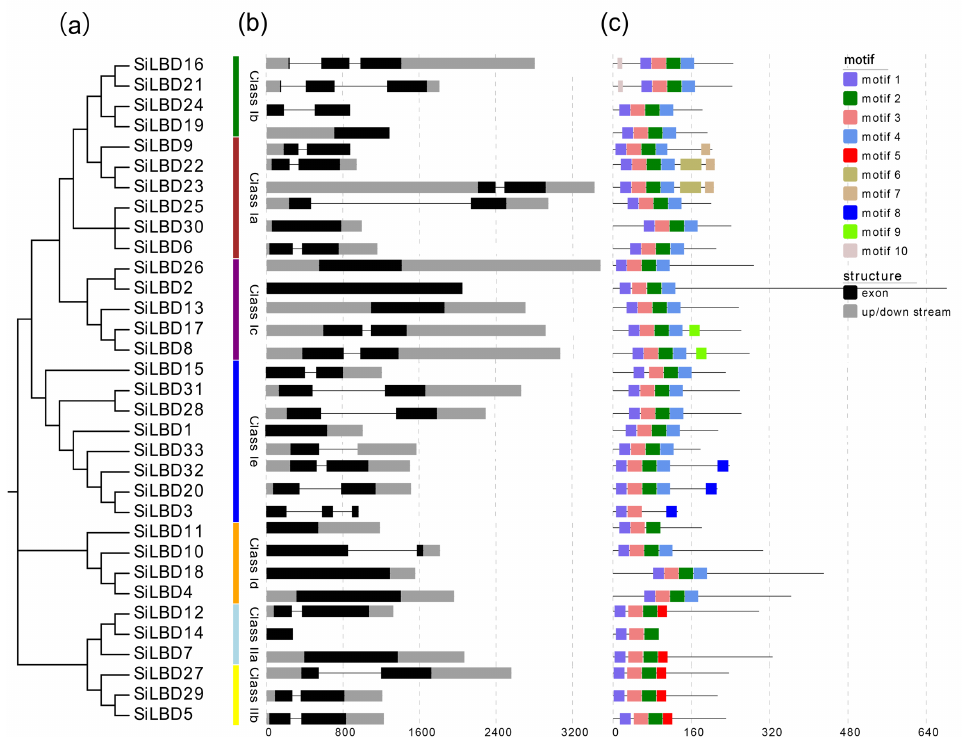
Figure 3. Gene structure and conserved motifs of SiLBDs. ( a ) SiLBDs are classified into seven groups Figure 3. Phylogenetic relationships, motifs, gene structures of SiLBDs.( a ) SiLBDs were classified into seven groups according to bootstrap valus; ( b ) Gene structures of SiLBDs. Exons and introns were indicated by boxes and lines according to bootstrap values; ( b ) gene structures of SiLBDs . Exons and introns are indicated by boxes respectively. ( c ) Different motifs of SiLBDs. Different boxes indicated different motifs; and lines, respectively; ( c ) different motifs of SiLBDs. Different color boxes indicate different